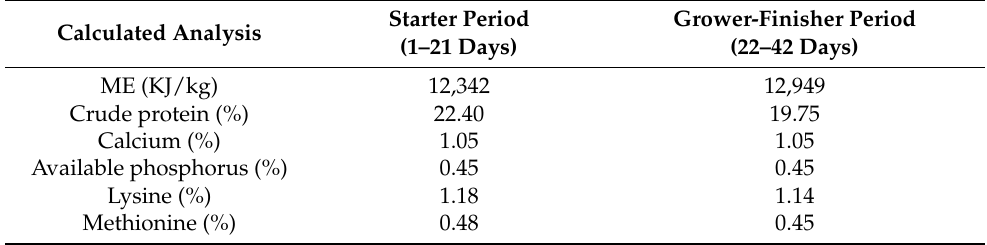
Table 1. Calculated chemical analysis of the corn-soybean basal diets of broiler